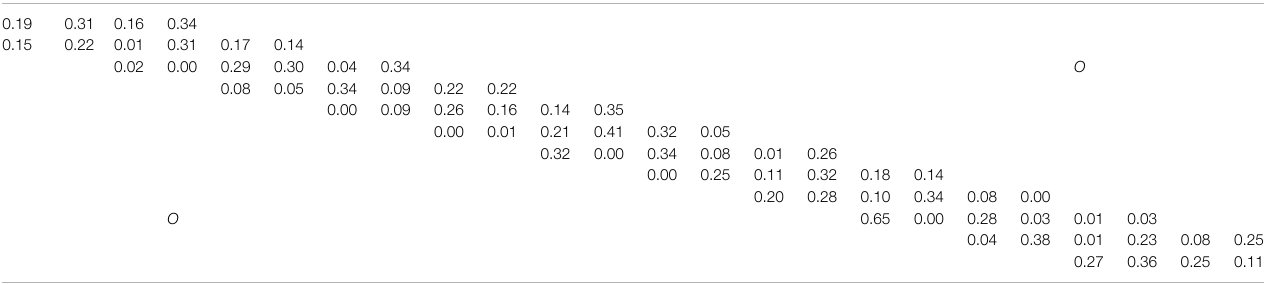
TABLE 5 | Components of matrix H .